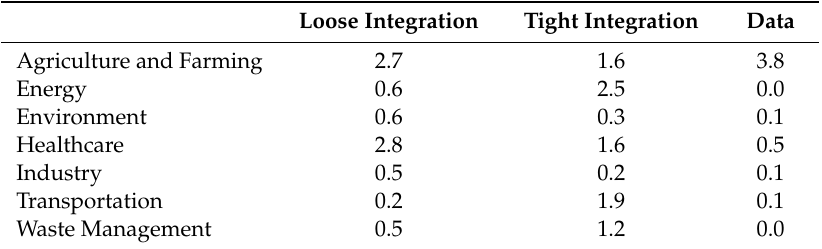
Table 17. Chi Square, between smart city subcategory, and three hypotheses.